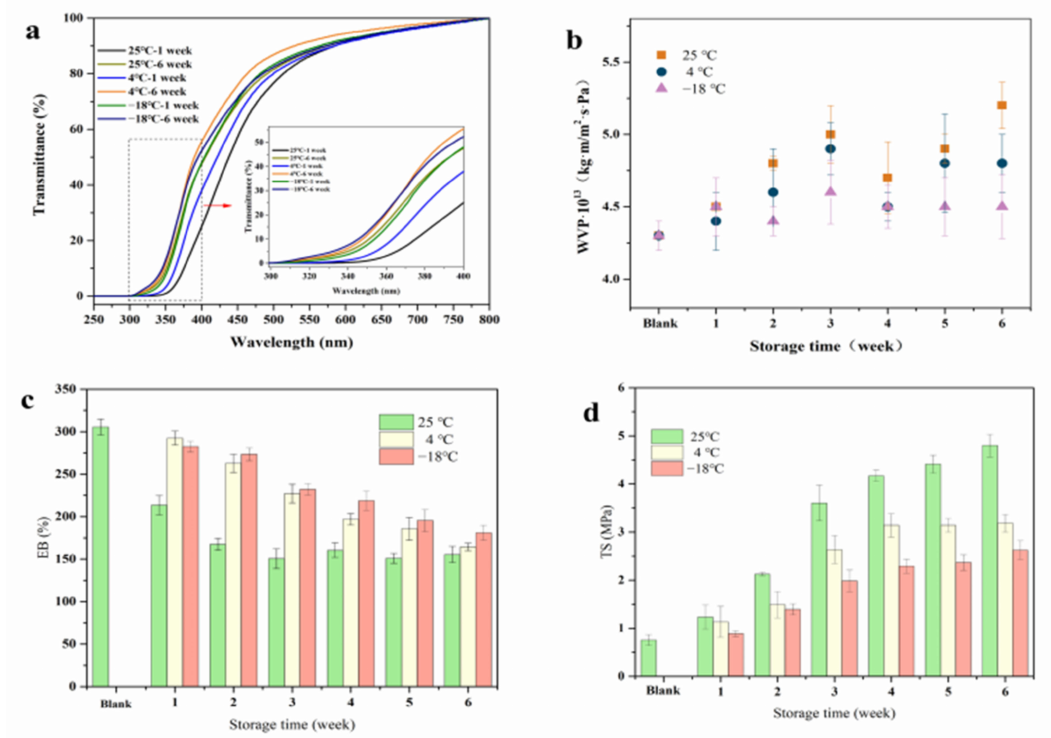
Figure 6. Transmittance ( a ), WVP ( b ), EB ( c ), and TS ( d ) of SPI films after storage for 6